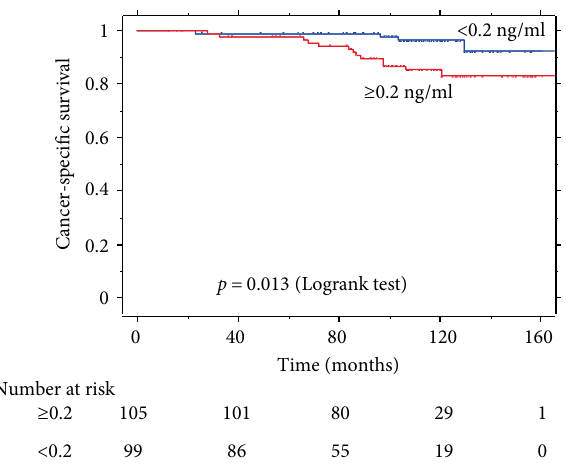
Figure 2: Kaplan–Meier survival curve of CSS by pre-RT PSA.